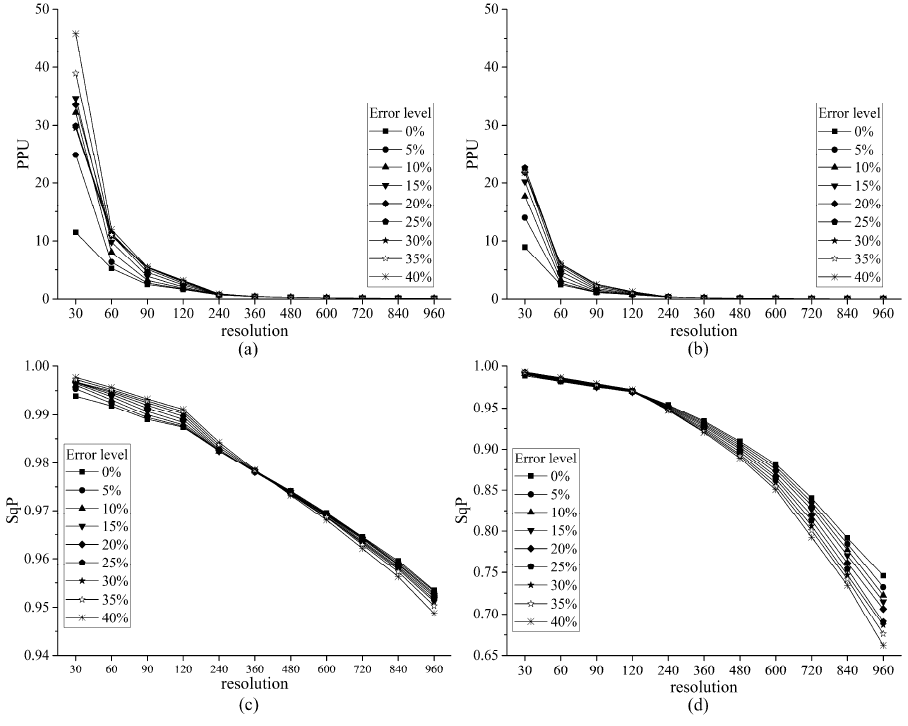
Figure 9. Changes of PPU and SqP in ASD1810, and ASD4550: ( a , b ) the changes of PPU and SqP, respectively, in ASD1810; and ( c , d ) the changes of PPU and SqP, respectively, in ASD4550.